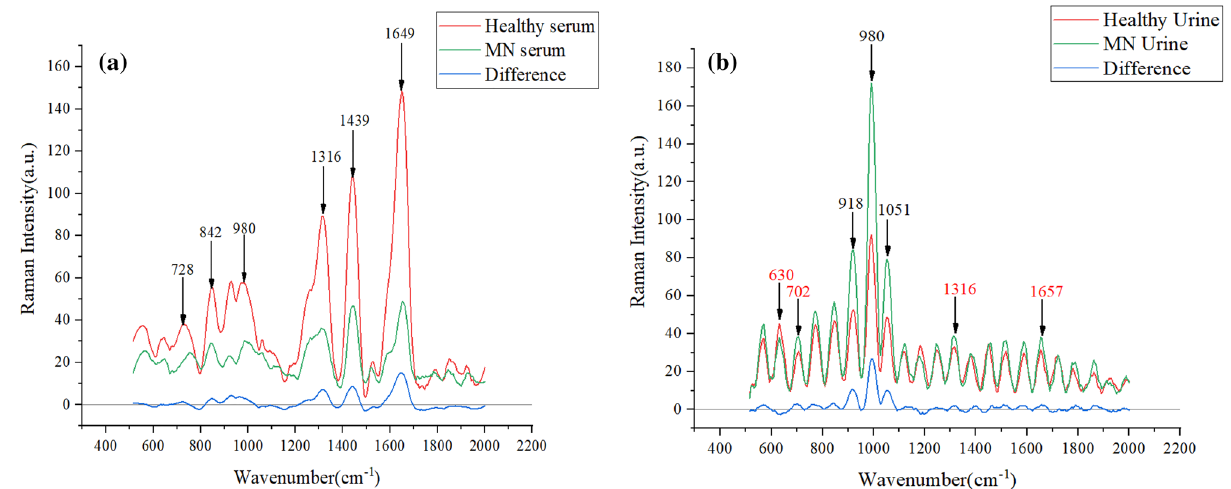
Figure 2. ( a ) Average spectra of serum and control group in membranous nephropathy ( b ) Average spectra of urine and control group in membranous